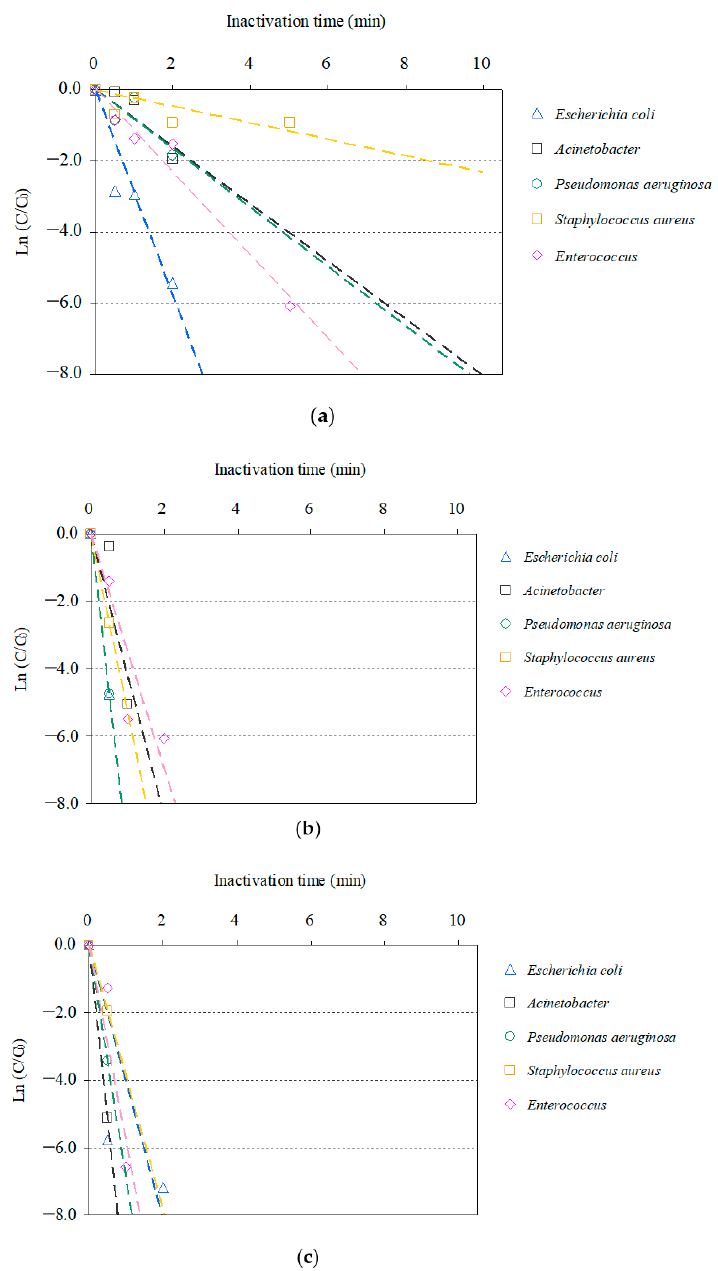
Figure 2. Relative residual antimicrobial-susceptible bacteria (AMSB) under O 3 -based AOPs treat- ment (C 0 : initial bacterial counts, C: bacterial counts after treatment): ( a ) O 3 /H 2 O 2 , ( b ) O 3 /UV, ( c ) O 3 /UV/H 2 O 2 .